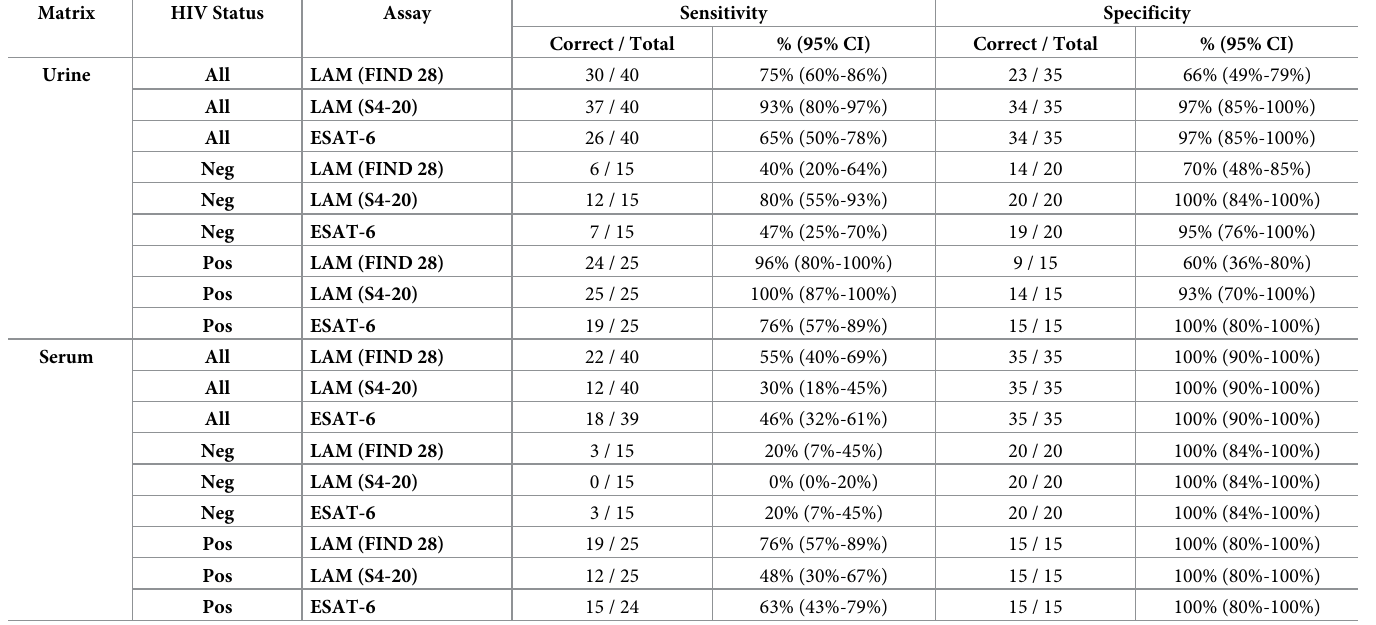
Table 2. Accuracy of LAM and ESAT-6 assays for measurements in urine and serum. LAM performance is provided for the FIND 28 and S4-20 capture antibodies. The table provides the measured sensitivity (correctly classified TB+ samples / total number of TB+ samples) and specificity (correctly classified TB- samples / total number of TB- samples). The values were calculated for the full sample set (All) or for the subsets of samples from HIV- and HIV+ subjects. 95% confidence intervals for the pro- portion were calculated using Wilson’s method.